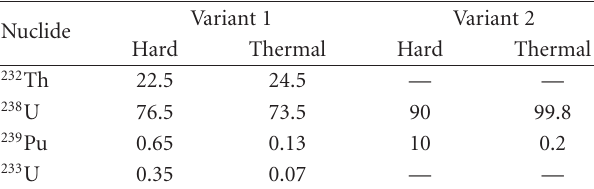
Table 1: Percentage of fuel materials in fuel rods using mass Table 2: Ratio of fissions in hard assemblies to total fissions in reactor with dependence on heavy metal layer thickness.